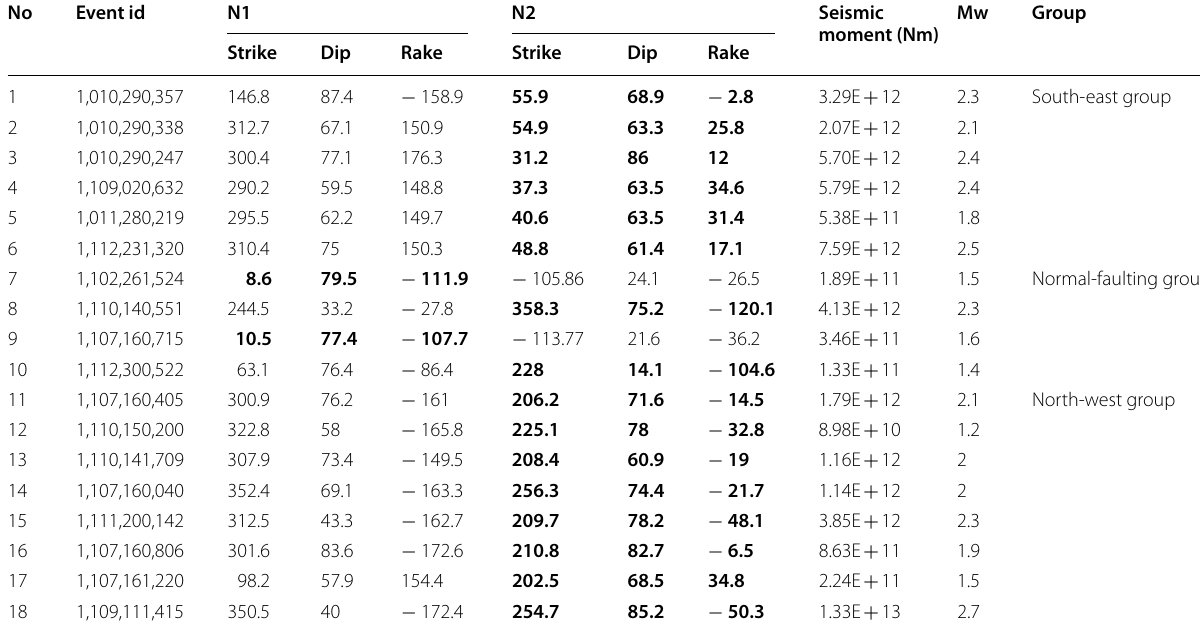
Table 3 A list of the fault plane parameters and their moment magnitude. The bold numbers are the interpreted fault planes. All these events are divided into three groups. The chosen fault plane are parameterized by bold characters